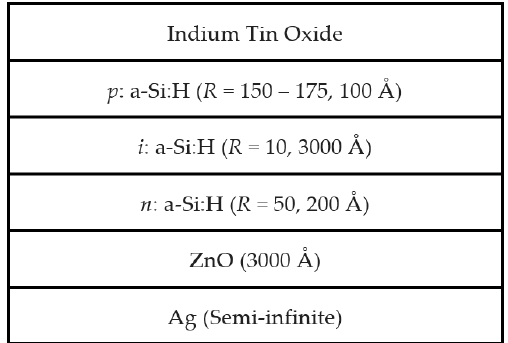
Figure 8. Schematic of a single junction a ‐ Si:H based solar cell prepared in the n ‐ i ‐ p configuration. Each amorphous or protocrystalline Si:H layer is optimized to a value of R with an intended thickness.